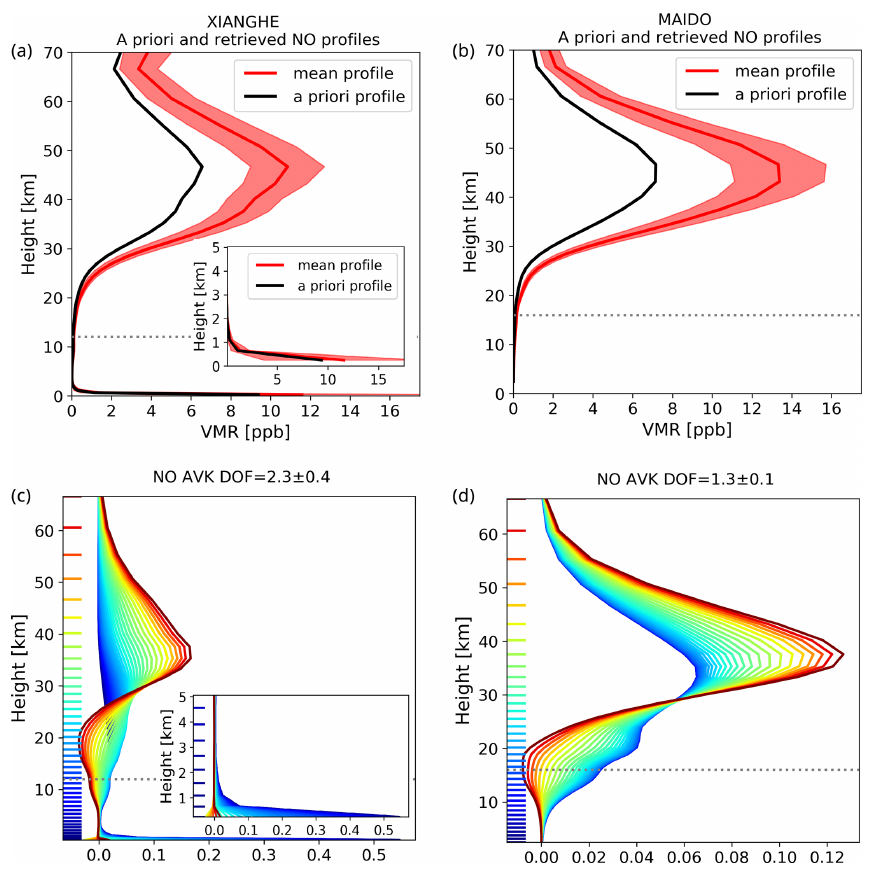
Figure 3. The a priori and retrieved NO profiles at Xianghe and Maïdo (upper panels), together with a typical averaging kernel (AVK) at each site (bottom panels). To better visualize the change near the surface, a zoom on the vertical range between 0 and 5km is also shown for Xianghe. The red shadow in the upper panels is the standard deviation of the retrieved profiles. The dashed line indicates the tropopause height.